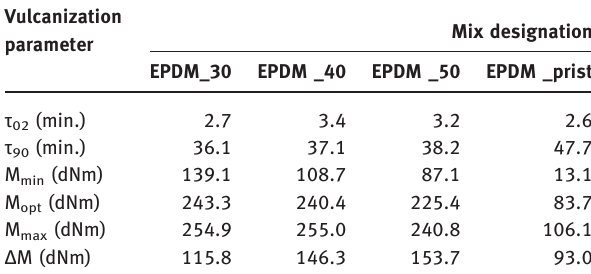
Table 2: Parameters of kinetics of vulcanization: scorch time ( τ 02), vulcanization time ( τ 90), minimal (Mmin), optimal (Mopt) and max- imal (Mmax) torque value and increase of torque ( Δ M).